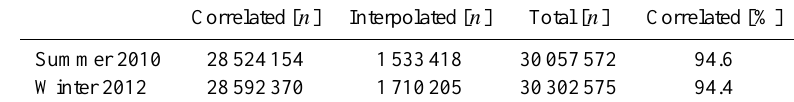
Table 2. Correlated vs. interpolated terrain points in summer and winter DSM over the entire test site.